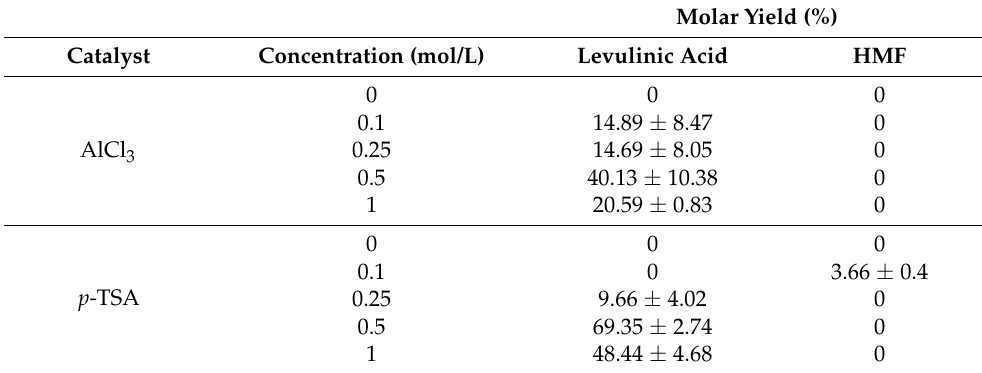
Table 1. 5-hydroxymethylfurfural and levulinic acid molar yields (%) depending on the acid concentration. Molar Yield (%) Catalyst Concentration (mol/L) Levulinic Acid HMF